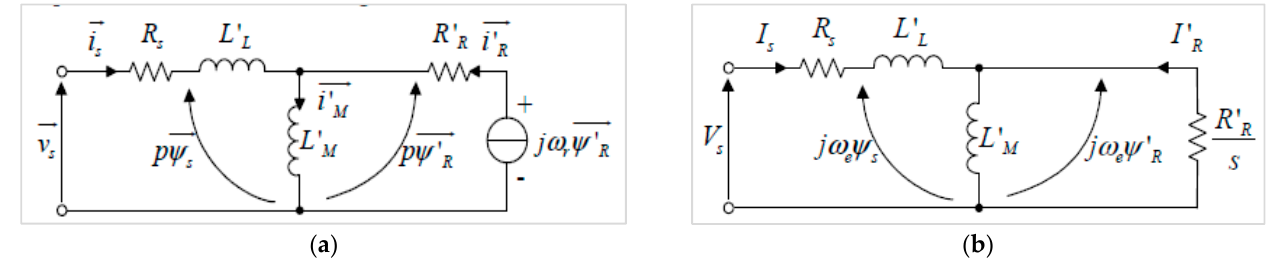
Figure 2. ( a ) Transient circuit of the inverse 𝛤 model; ( b ) steady-state inverse 𝛤 model [20].